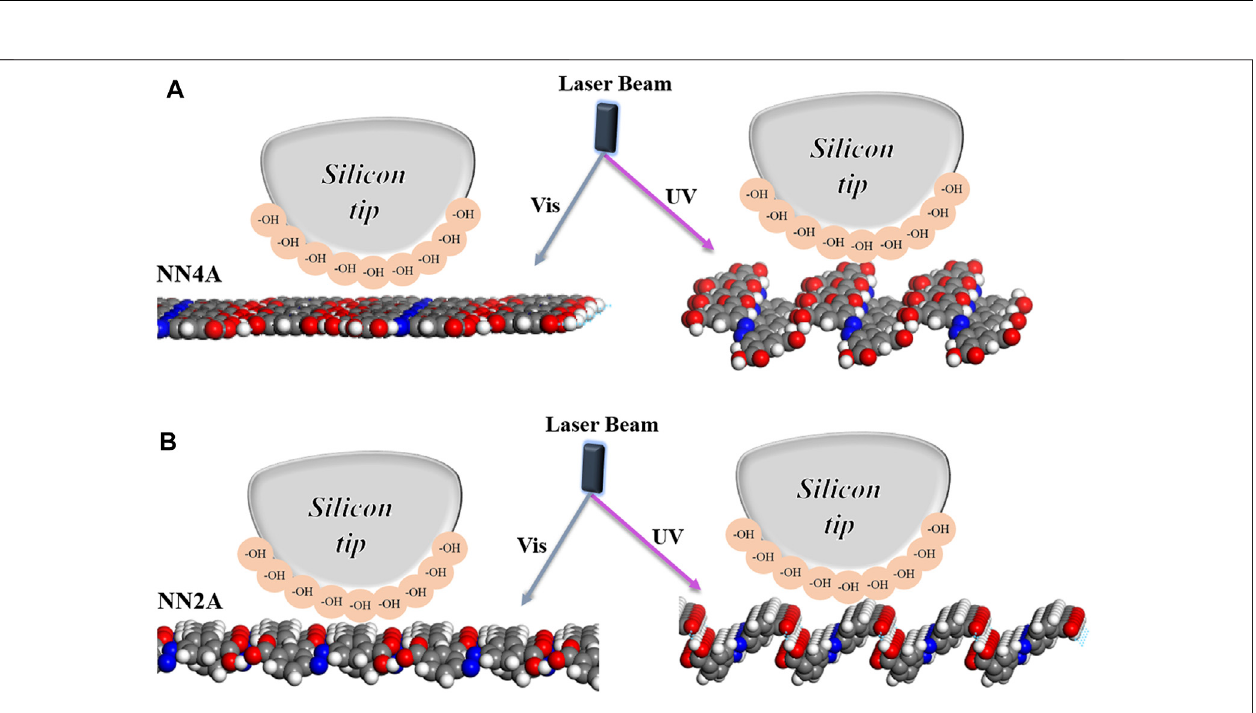
Frontiers in Chemistry |